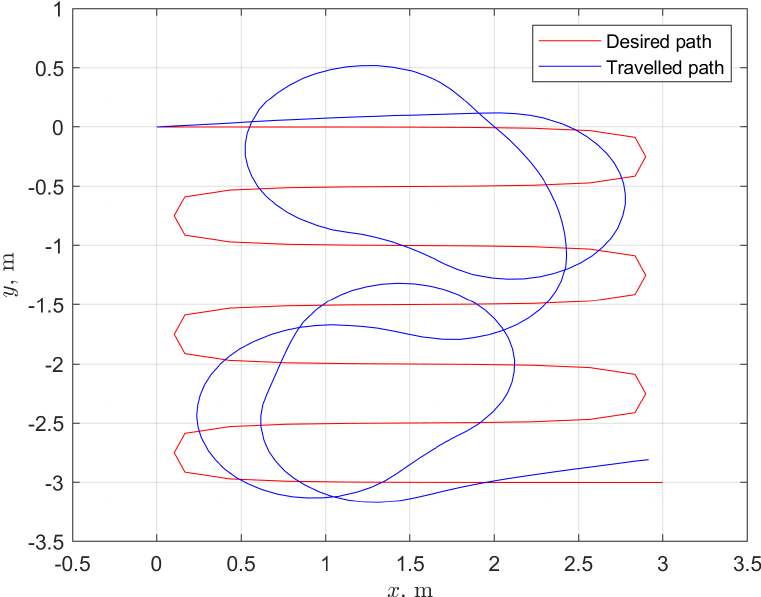
Figure 14. Desired path vs. actually traveled path for the mid value of the cost function equal to 1.0930—track